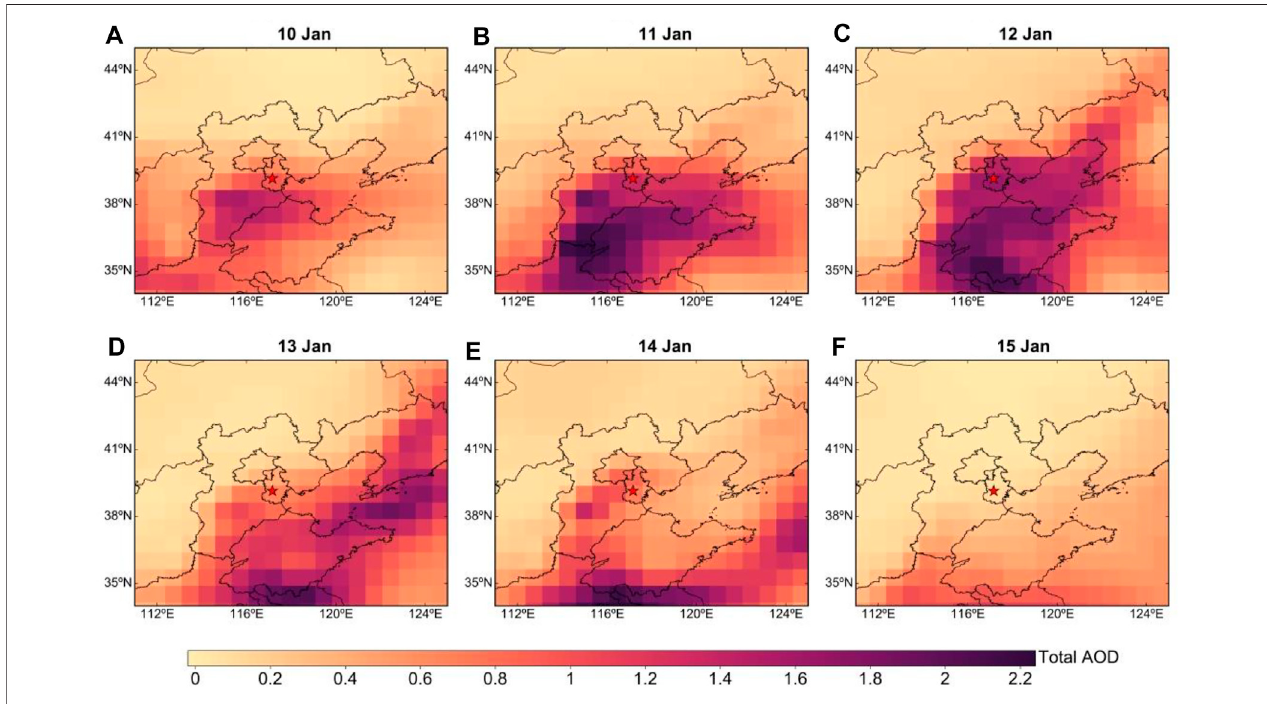
FIGURE 8 | Spatial distribution of daily AOD from 10 to 15 January 2019 in Tianjin shown in (A – F) .